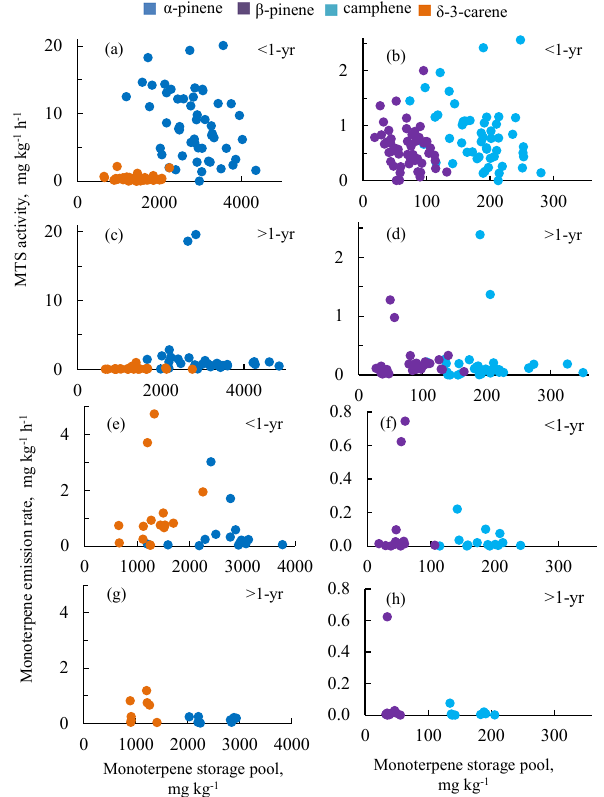
Figure 4. Relationship between monoterpene storage pools ( x axes) and MTS activities (a–d) and between monoterpene emissions (e– h) in <1-year-old (a, b, e, f) and >1-year-old (c, d, g, h) needles. Plots for more abundant compounds ( α -pinene and δ -3-carene) on the left and for less abundant compounds ( β -pinene and camphene) on the right. Emissions originated from both <1-year-old and >1- year-old needles and a twig. Data from trees #3 and